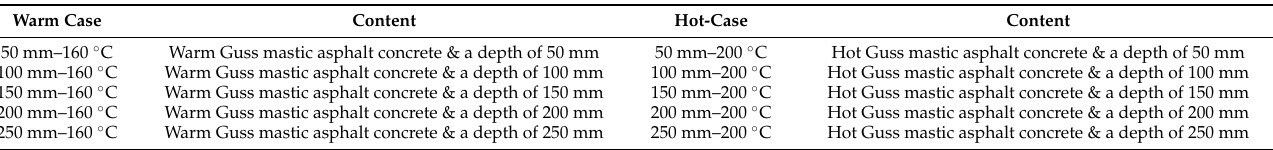
Table 5. Overview of numerical analysis cases.